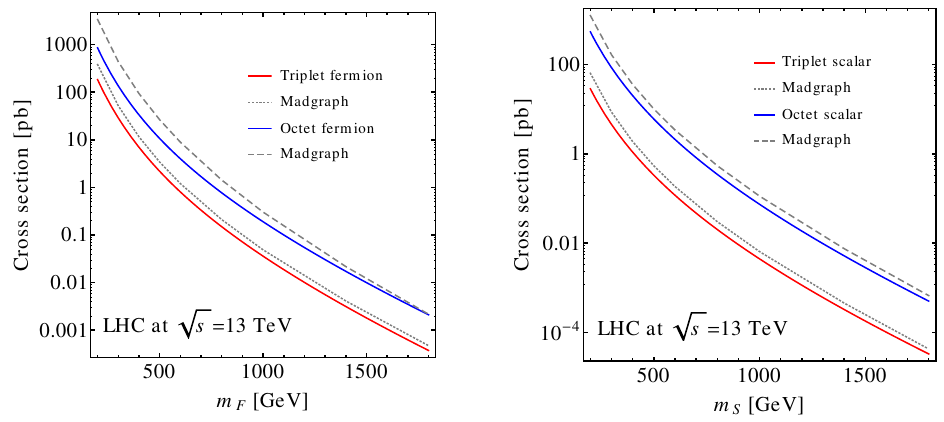
Figure 9 . Comparison of the analytical formulae eq. (C.1) and eqs. (C.20)–(C.23) with the results of the numerical simulation performed with MadGraph5_aMC@NLO , for fermions (left panel) and scalars (right panel). SU(3) triplets are indicated as solid red lines, while the SU(3) C lines. Dotted and dashed grey lines denote the MadGraph5_aMC@NLO results,